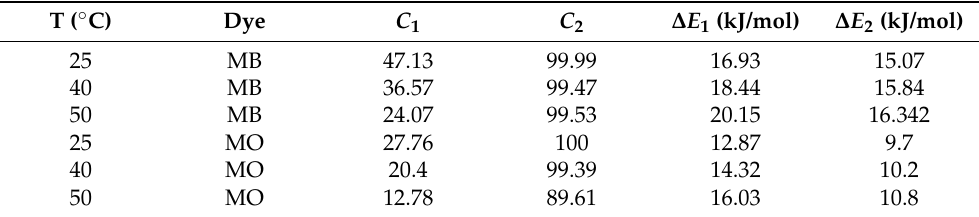
Figure 7. Adsorption energies for ( a ) MB and ( b ) MO adsorption on Rt/BC adsorbent. Table 3. Energetic parameters of the double layer model for the MB and MO uptake on Rt/BC